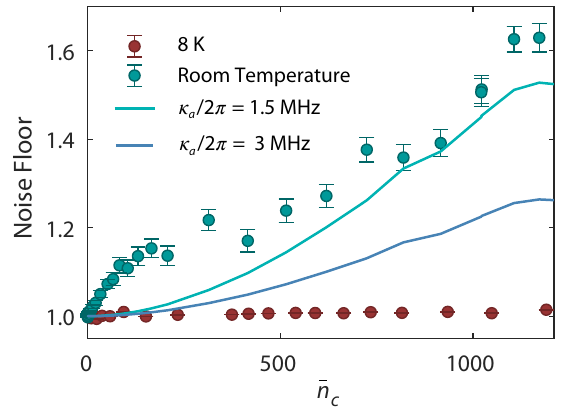
FIG. 3. Noise floor from the incoherent optomechanical spec- troscopy of sideband-cooled OMCs at different intracavity pho- ton numbers. The noise floor is normalized to the shot noise floor. The red circles correspond to the OMC with κ/ 2 π ∼ 1.7 GHz at approximately 8 K, while the green circles correspond to the OMC with κ/ 2 π ∼ 220 MHz under ambient conditions. The green and blue curves correspond to the theoretical plots for κ a of 2 π × 1.5 MHz and 2 π × 3 MHz, incorporating the inferred κ eff and κ a σ 0 ((cid:8) m ) from coherent cavity